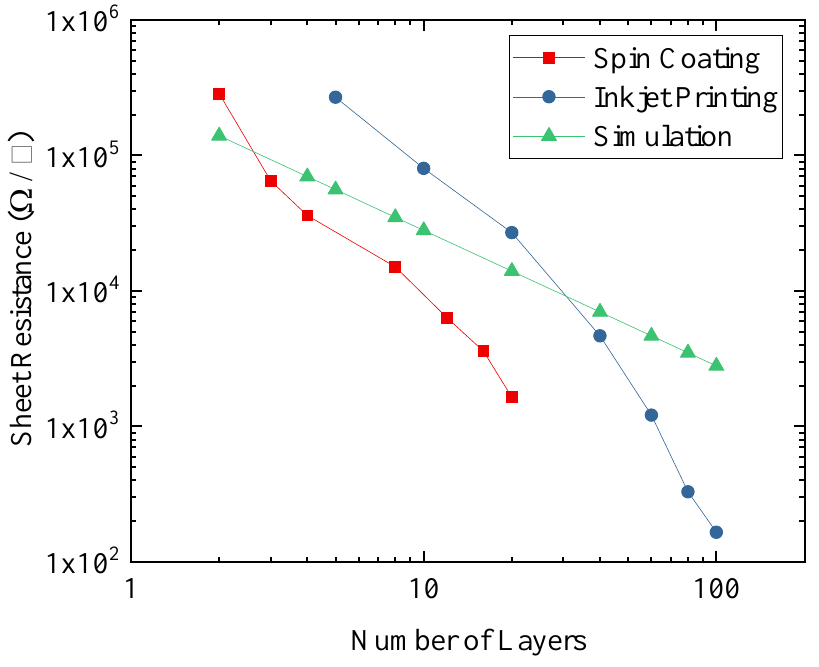
Figure 18. DC four-point probe measurements of sheet resistance for spin-coated and inkjet-printed MWCNT thin films, and the simulated sheet resistance.